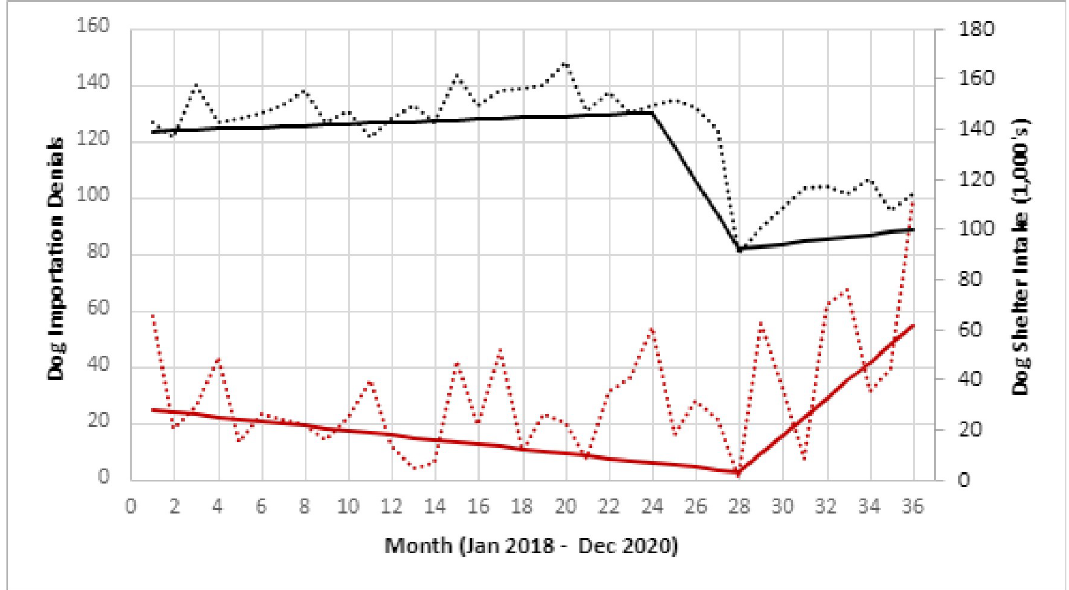
Fig 1. Trends in the intake of dogs in animal shelters compared to dog denials, United States, 2018–2020 � † . � Black dotted line reflects the monthly intake of dogs in shelters. The solid line represents the modeled values from trend analysis and show three